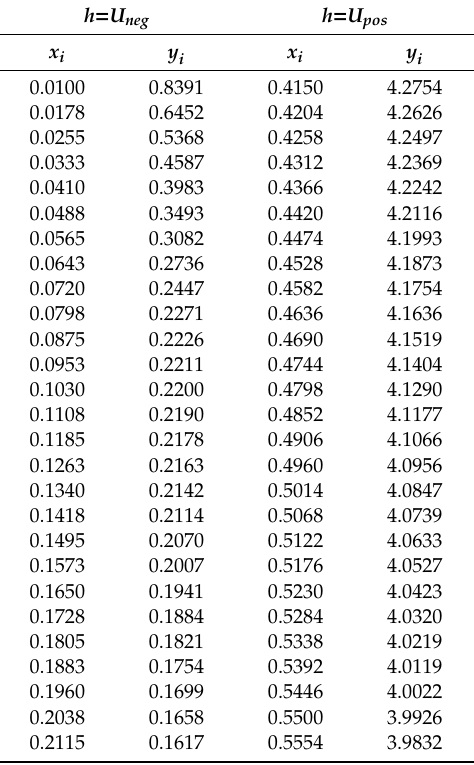
Table A1. Values of the interpolation nodes of the electrode equilibrium potential profiles. h = U neg h = U